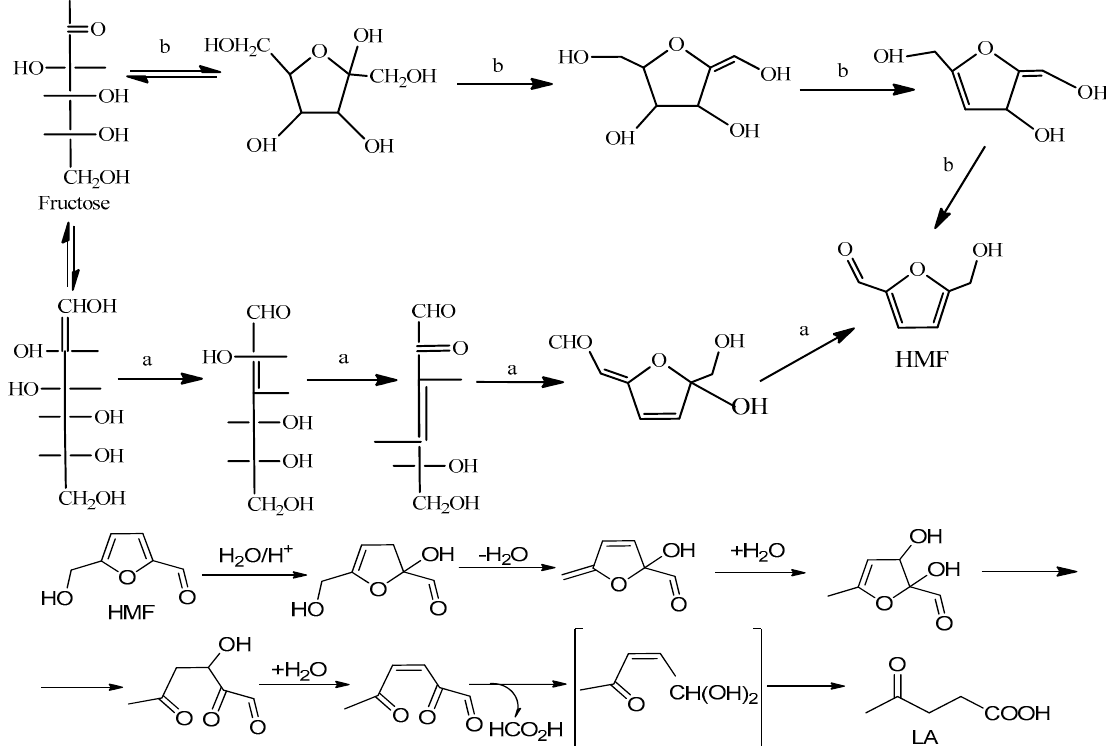
Figure 5. Possible dehydration mechanisms for formation of HMF ( up ) acyclic route; ( down ) cyclic route and the formation of LA from HMF.